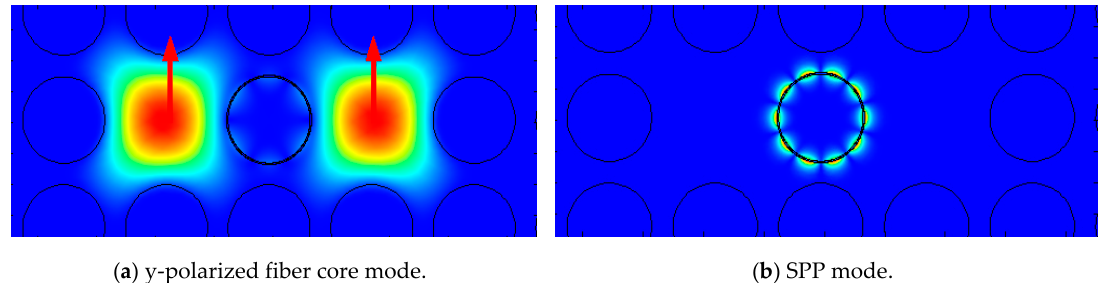
Figure 4. The optical field distribution of ( a ) the y-polarized fiber core mode and ( b ) SPP mode and the arrows represent the direction of the electric field.